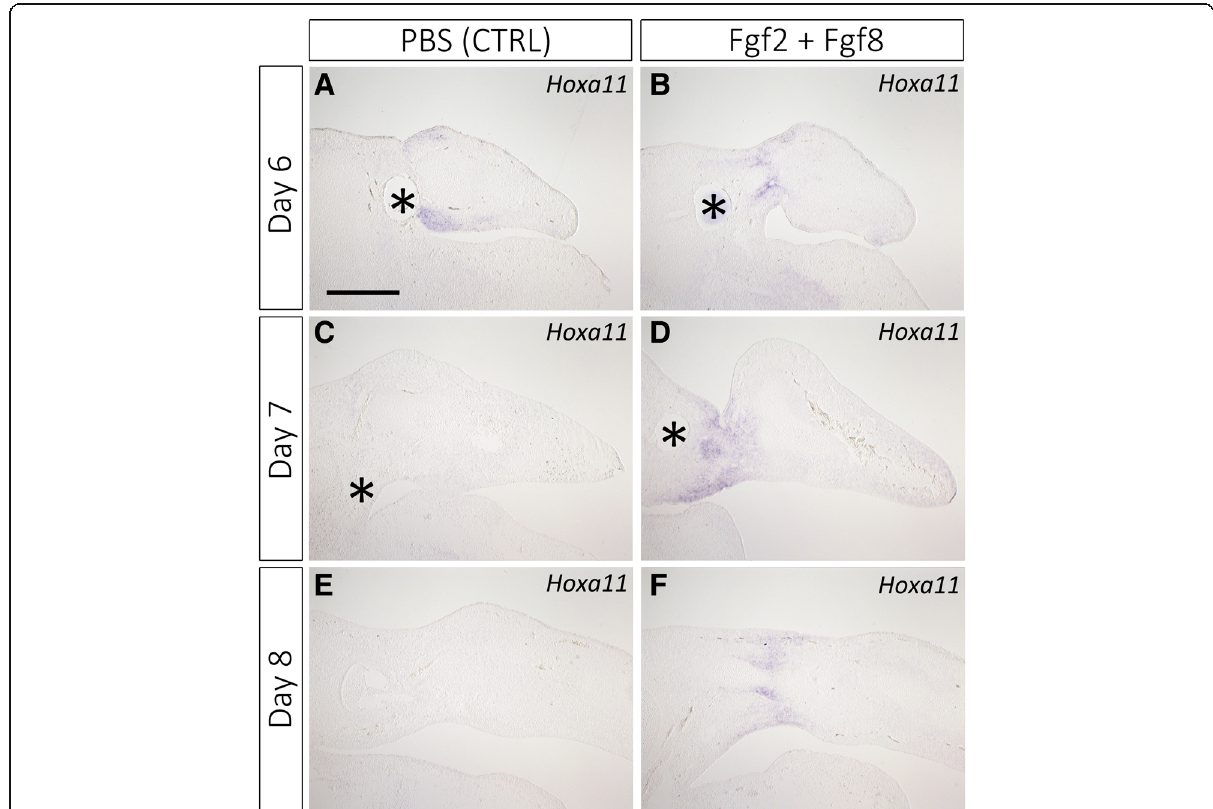
Fig. 3 HoxA11 expression pattern in the operated limbs. HoxA11 expression in the control (PBS) samples ( a, c, e ) and Fgf2 + Fgf8 bead-grafted limb buds ( b, d, f ). a , b HoxA11 expression remained at the distal parts on day 6 (2 days after surgery). HoxA11 expression disappeared in the control samples at later time points, however ( c, e ). d , f HoxA11 expression was observed in the proximal region in the Fgf2 + Fgf8 bead-grafted limbs. Asterisks indicate the grafted beads. The scale bar in A is 500 μ